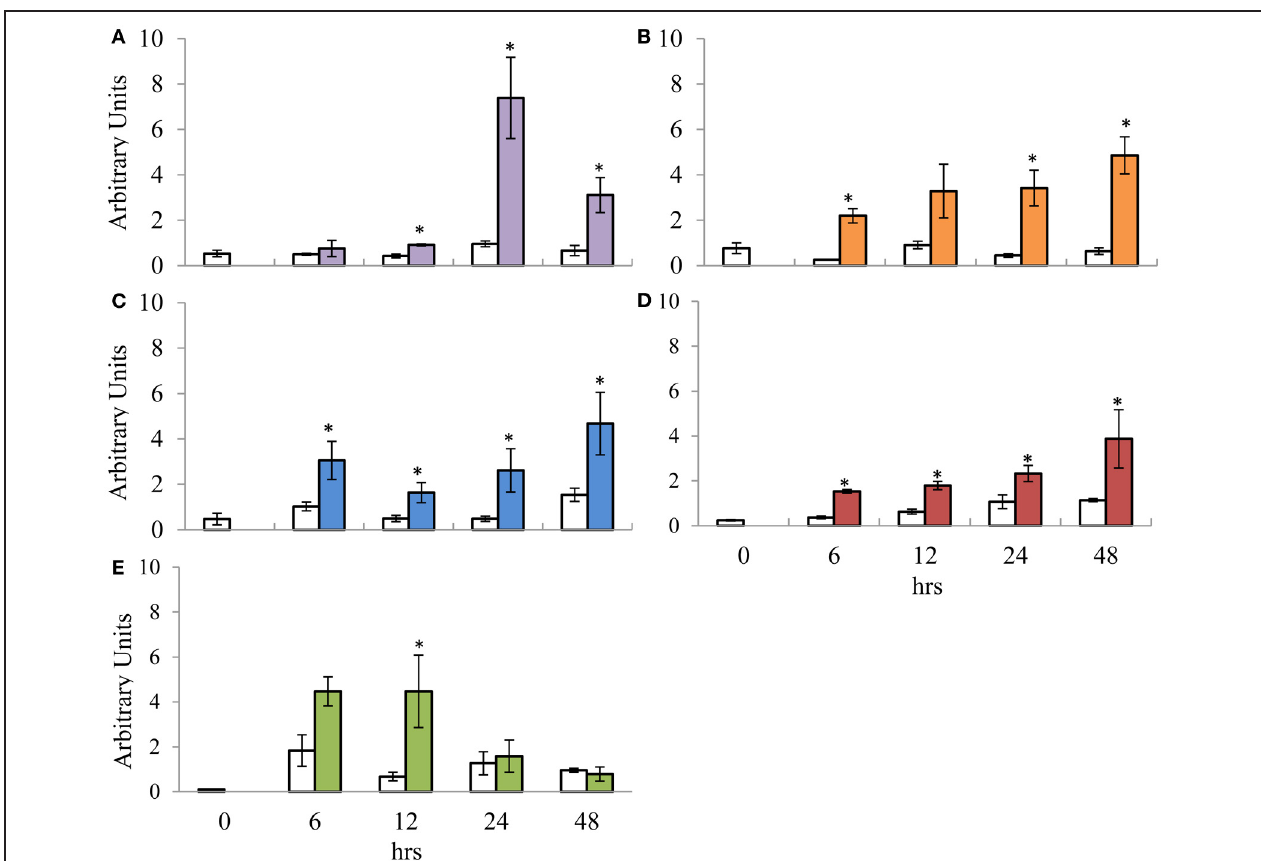
FIGURE 3 | Relative transcript abundance of putative orthologs for SA and MeJA signature defence genes assessed during the time course trial. (A) EgrPR2 ; (B) EgrPR5 ; (C) EgrPR3 ; (D) EgrPR4 ; (E) EgrLOX2 . The y-axis represents the relative expression ratios expressed in arbitrary units. The x-axis represents the time course (h) post-treatment with 5mM SA (A and B) and 100 μ M MeJA (C–E) .